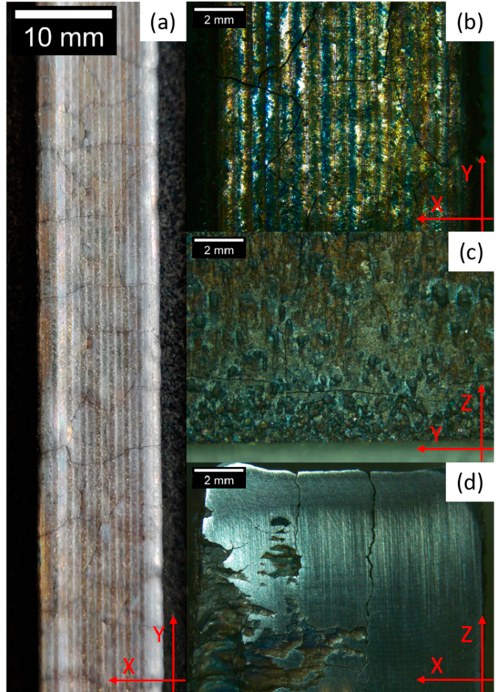
Figure 9. Horizontal bars built using shielding gas. Top ( a , b ), side ( c ) view and cross-section ( d ).